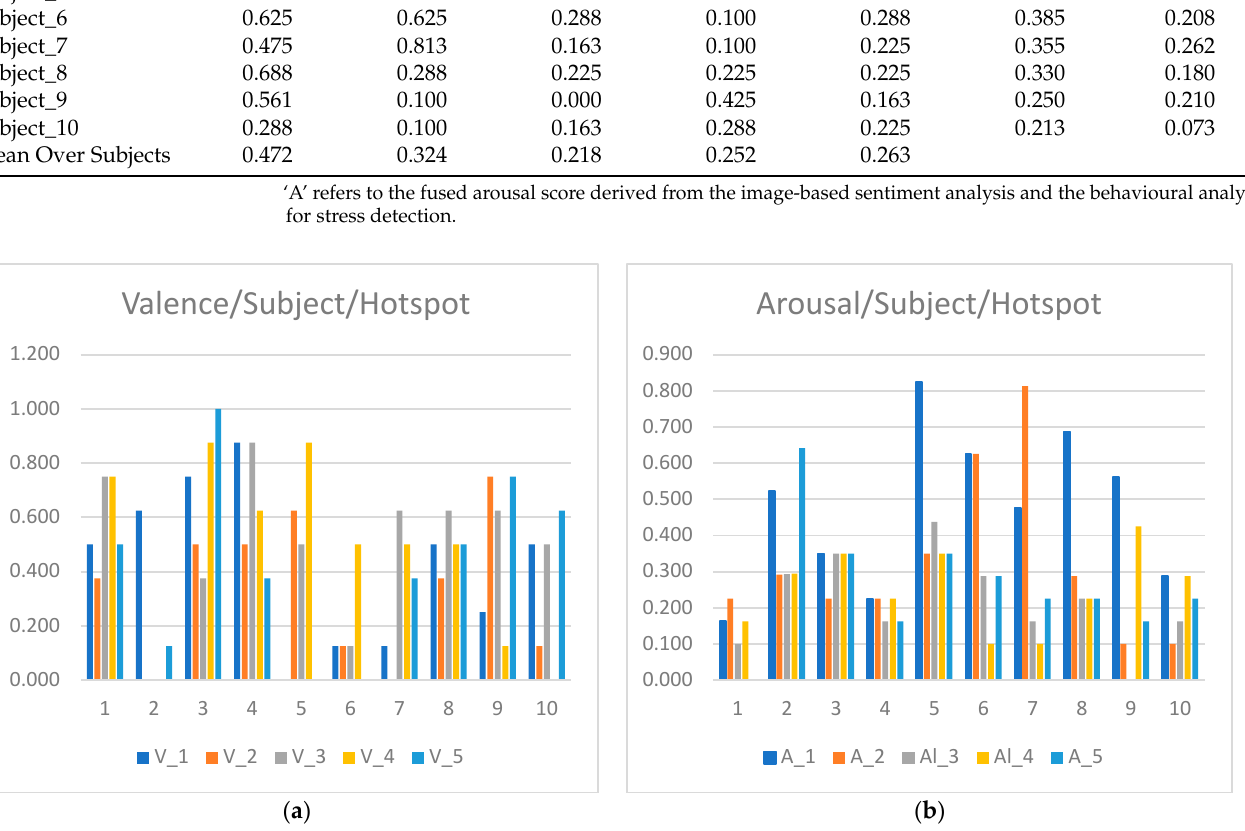
Figure 10. Graphical representation of the ( a ) valence and ( b ) fused arousal scores for each subject per hotspot.